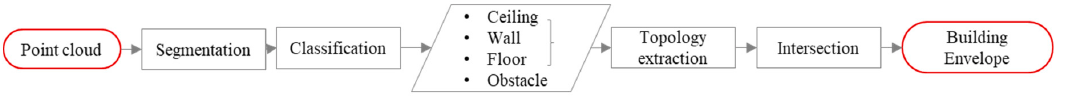
Figure 1. Workflow of the building envelope reconstruction.